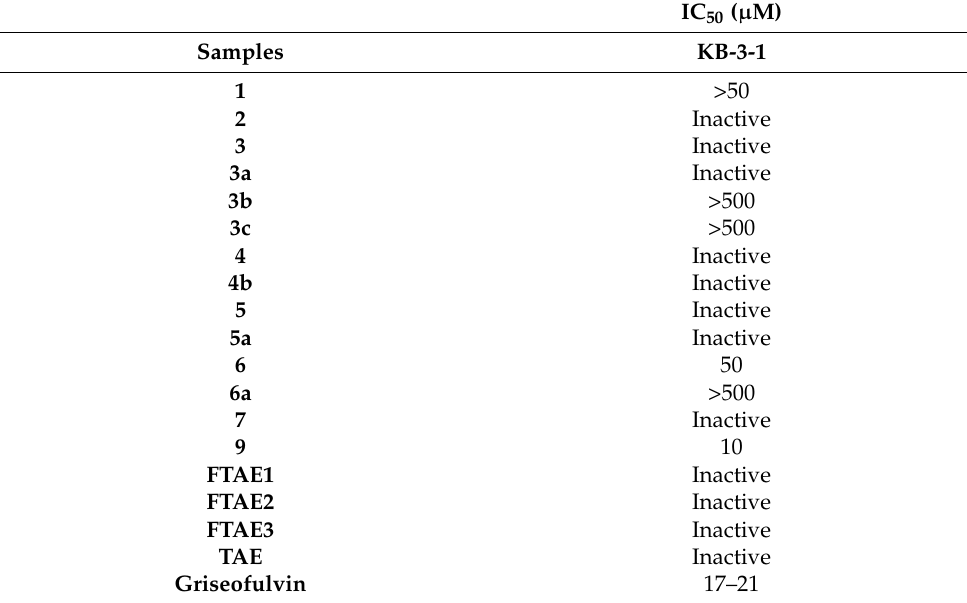
Table 2. IC 50 ( µ M)valuesofcytotoxicactivityoftheextract, fractions, isolates,